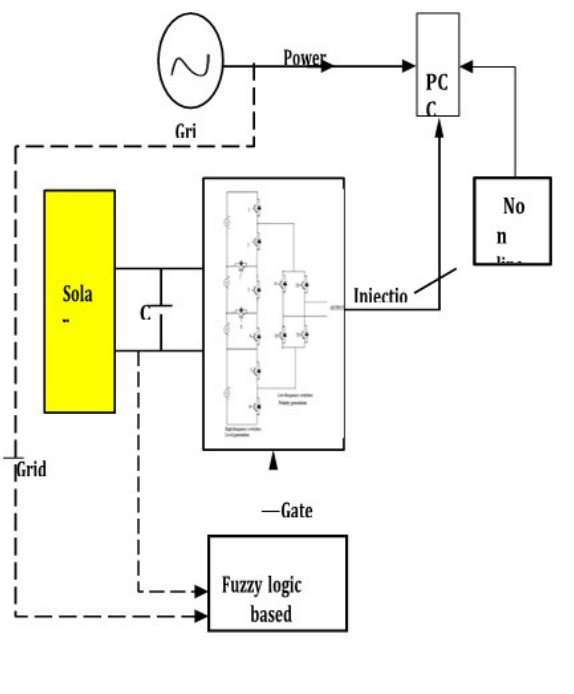
Figure 1. Block Diagram of Proposed Distributed